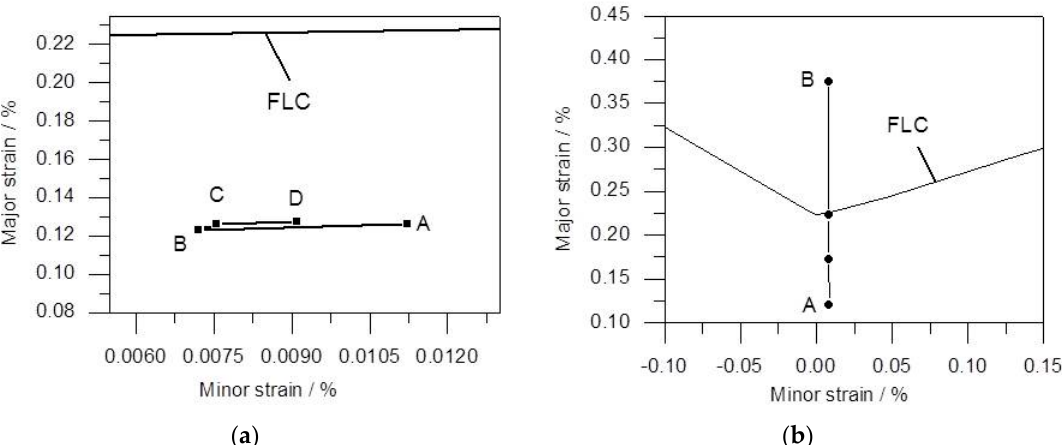
Figure 16. Strain path of the nodes located in the middle of convex surface: ( a ) roller hemming and ( b ) die hemming.